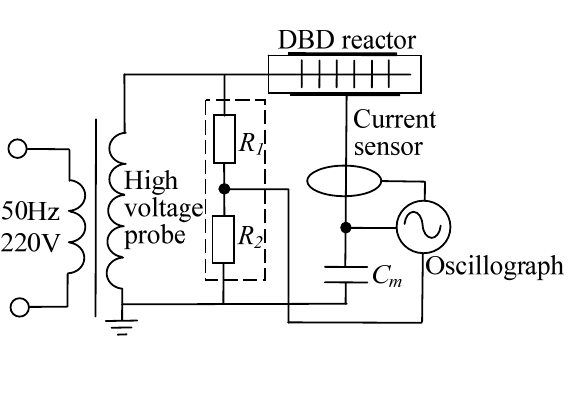
Figure 2. DBD experimental